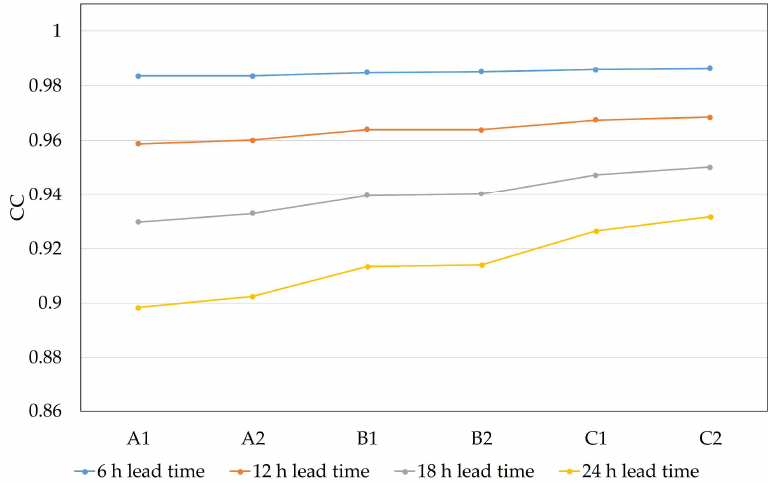
Figure 2. Correlation coefficient of the A, B, and C models in the testing phases. CC: correlation coefficient.